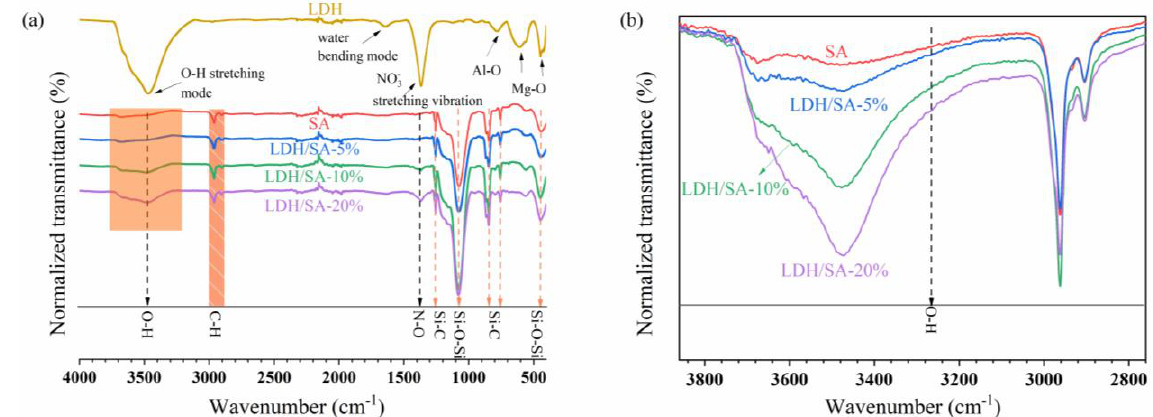
Figure 7. The FTIR spectra for the MgAl-LDH, SA, and LDH/SA composites ( a ) and the locally amplified IR spectra within the range of 2760–3860 cm − 1 ( b ).